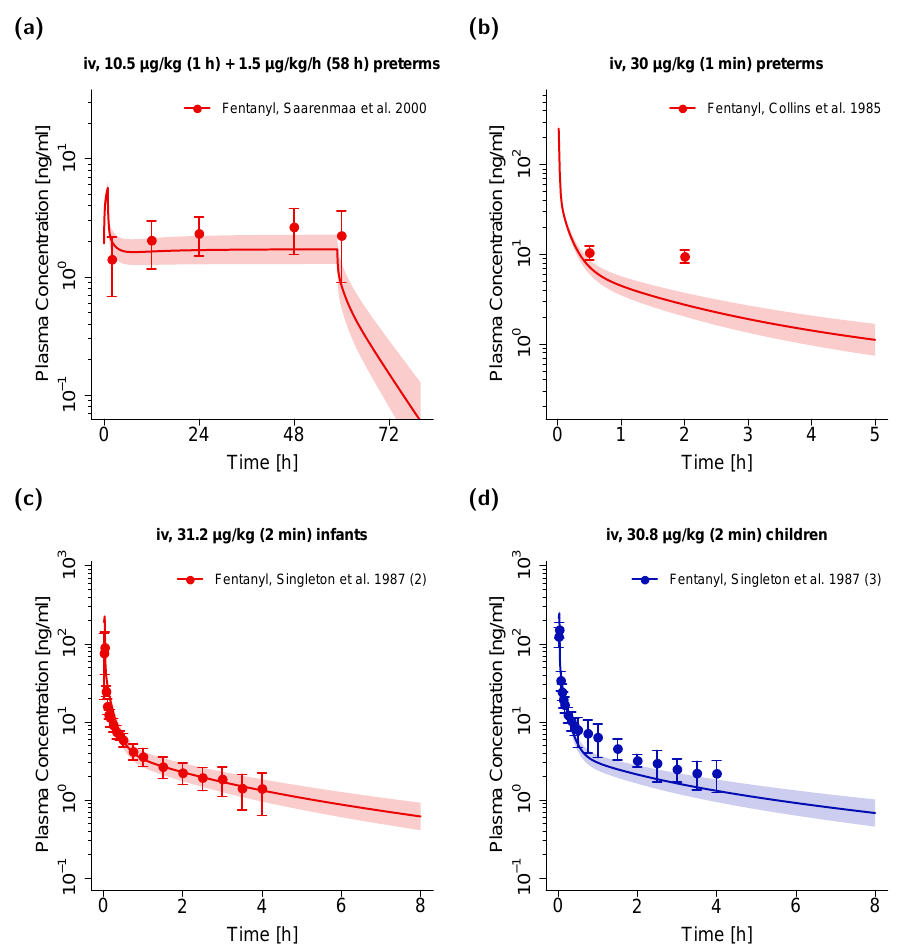
Figure 5. Fentanyl (red: arterial blood; blue: venous blood from central venous catheters) predicted and observed plasma concentration–time profiles after intravenous administration in preterm neonates ( a , b ), infants ( c ) and young children ( d ). Population simulations ( n = 100) are shown as lines with shaded areas (geometric mean and geometric standard deviation). Observed data is shown as circles with standard deviation. References with numbers in parentheses link to a specific observed dataset ID described in Table 2. Predicted and observed area under the plasma concentration–time curve from the first to the last data point (AUC last ) values are compared in Table S5 of the Supplementary Materials. Predicted and observed plasma concentration–time profiles of all studies in pediatrics are shown in Section 3.2 of the Supplementary Materials both on a linear and a semilogarithmic scale. iv: intravenous, preterms: preterm